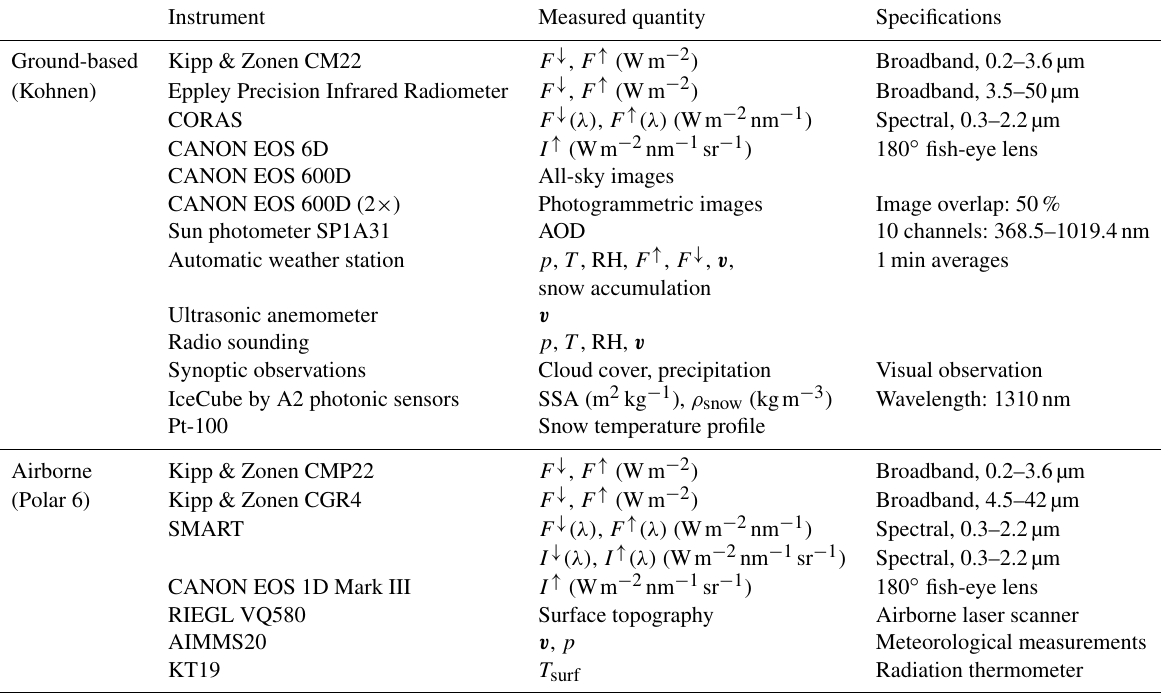
F ↓ : downward irradiance; F ↑ : upward irradiance; λ : wavelength (indicates spectral quantity); I ↑ : reflected radiance; AOD: aerosol optical depth; p : pressure; T : temperature; RH: relative humidity; v : wind vector; SSA: specific surface area; ρ snow : snow density; T surf : surface